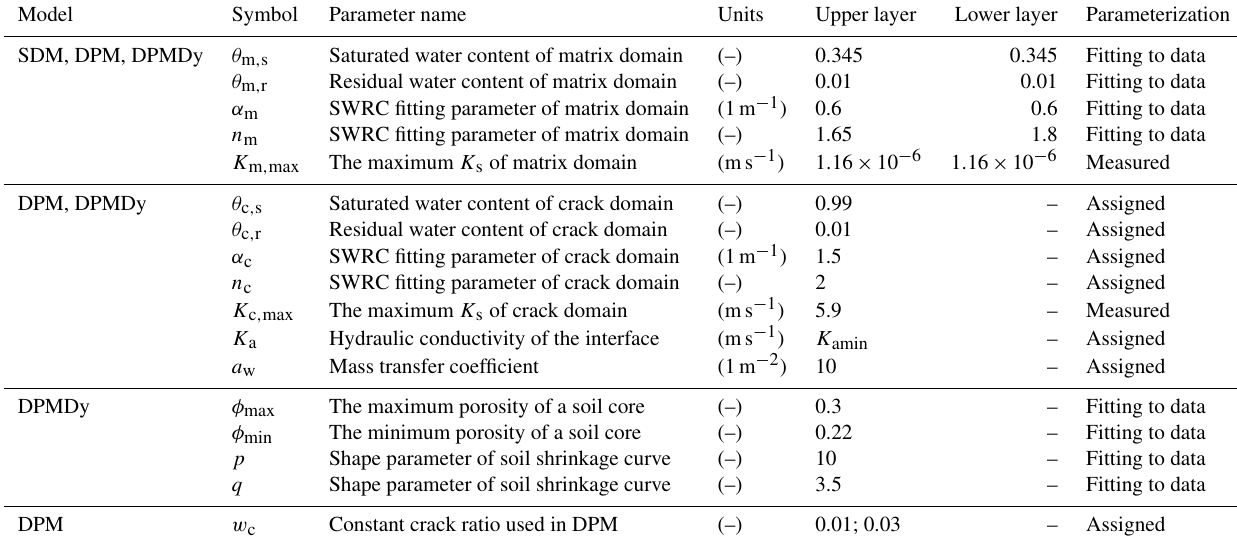
Table 3. Summary of parameters and parametric methods for the SDM, DPM and